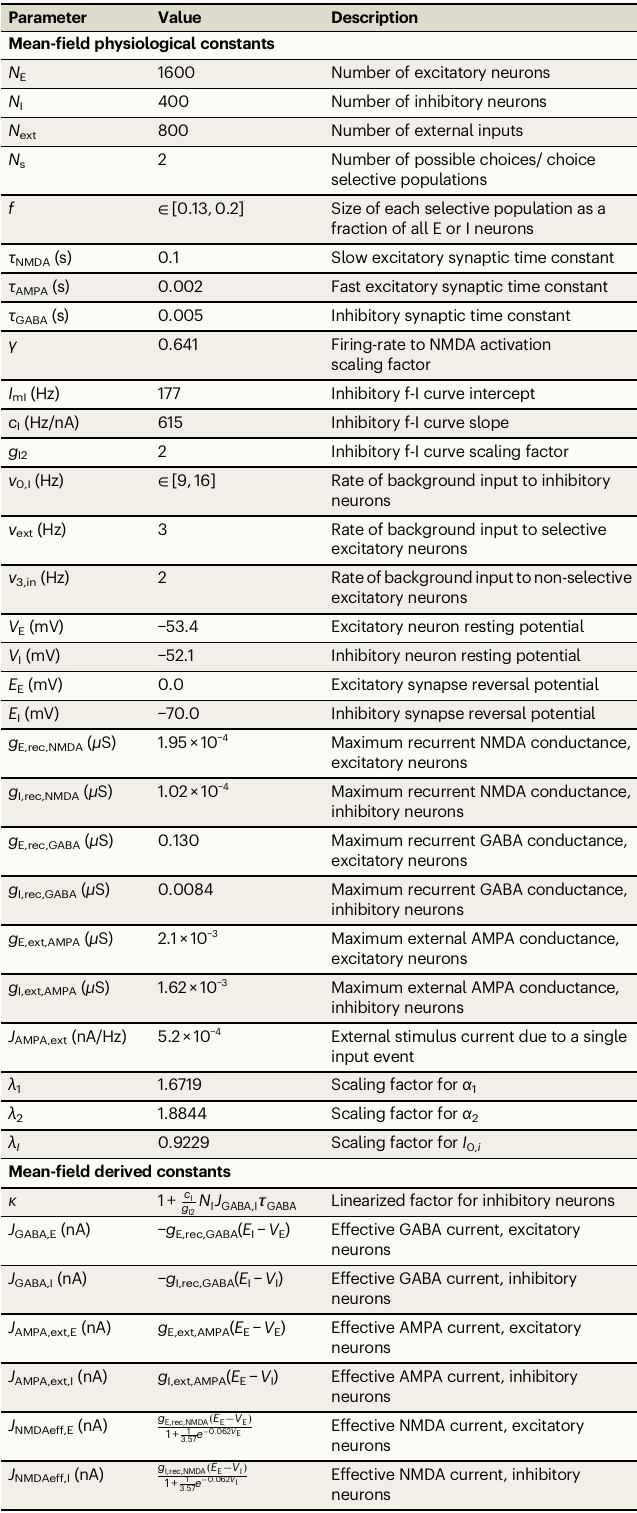
Table 1 | Mean- fi eld model parameters